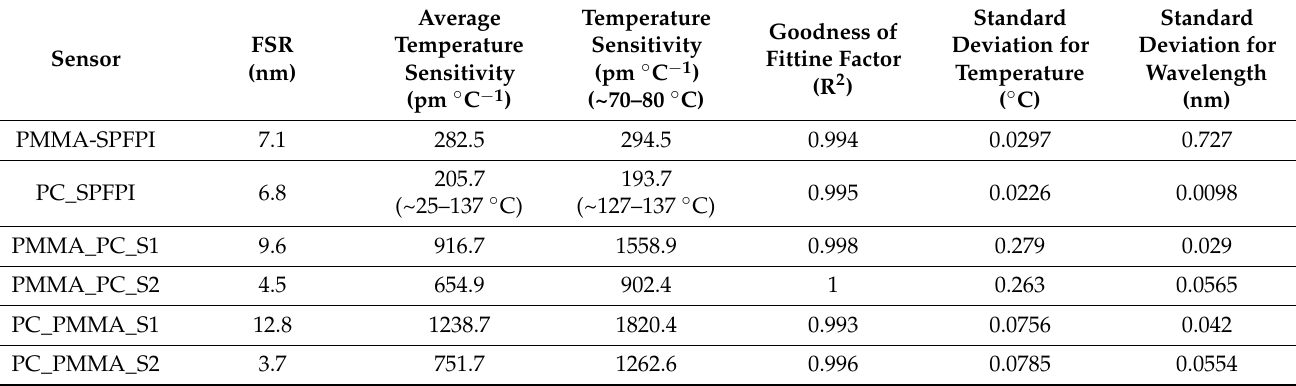
Table 1. Comparative study and results of the SPFPI and DPFPI